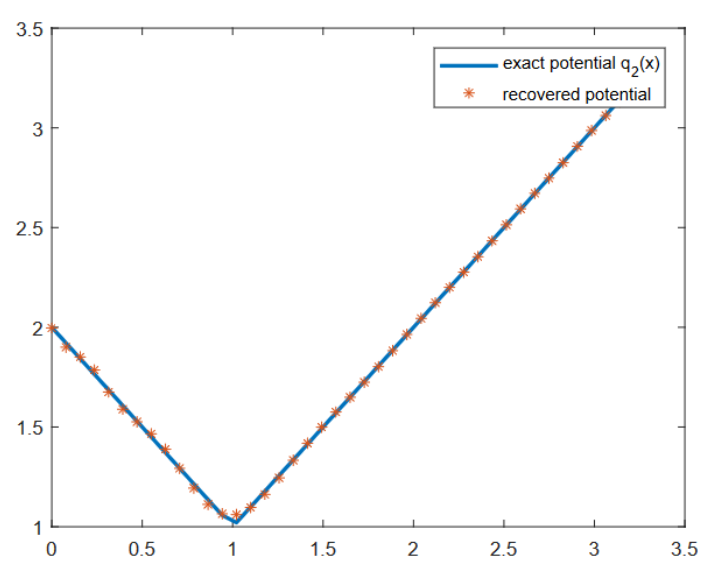
Figure 2. Potential q 2 ( x ) recovered from the data of type (3) with 25 points ρ k distributed uniformly on the segment in the complex plane [ − 1.5 + 0.1 i ,1.5 + 0.1 i ] and N = 9.